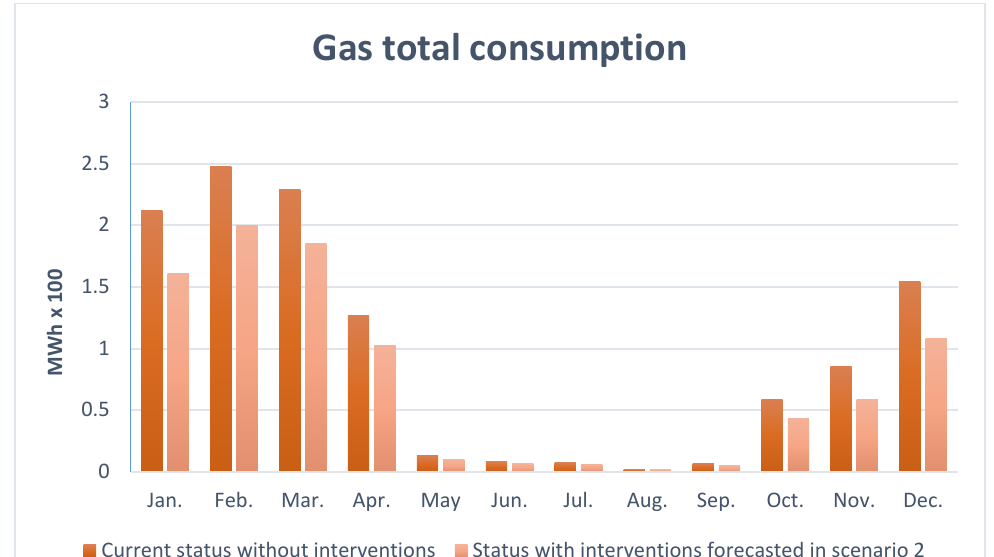
Figure 18. Comparison of CO 2 emissions of the building over the year between the current and future state with the energy interventions forecasted in scenario 2.